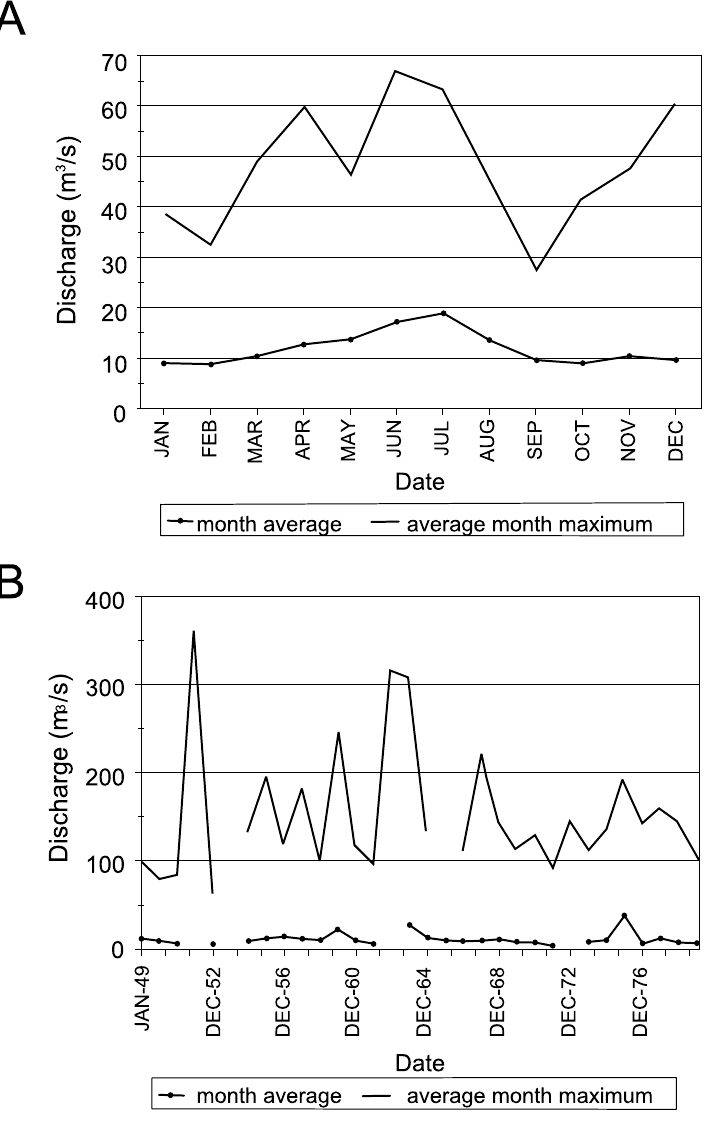
Fig. 2 – A) variation of the mouth average and maximum discharges for the Jaguaripe River, between 1949 and 1978, 30km inland from Garcez Point. B) maximum and average mouth discharges for Jaguaripe River, 30km inland from Garcez